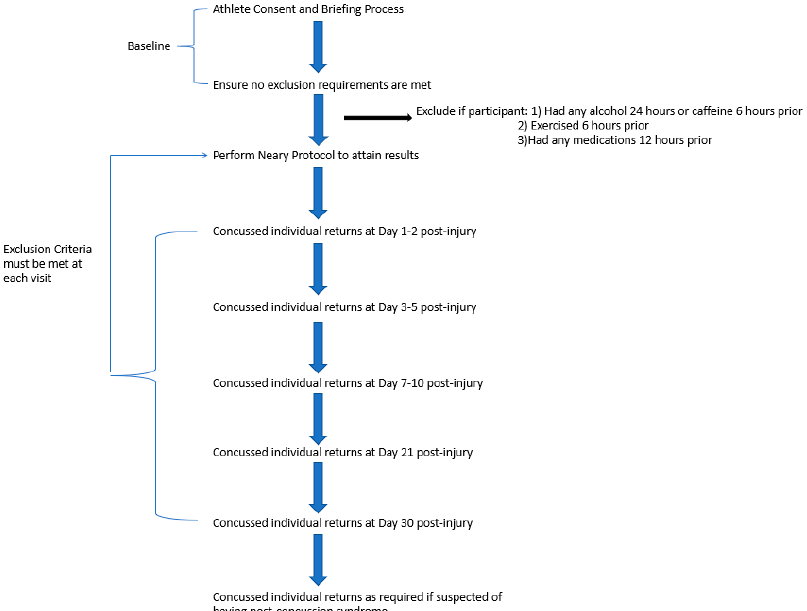
Figure 1. Study Layout and Participant Flow Chart.